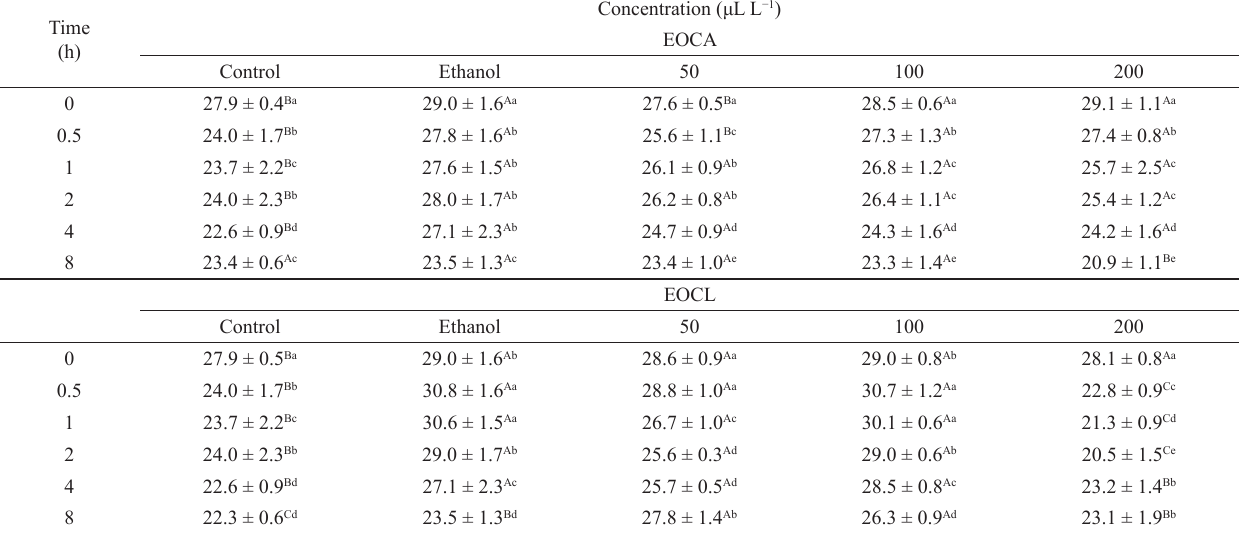
Fig 1. Net ion (Na + , K + , Cl − ) fluxes ( a-b ) and ammonia excretion ( c-d ) in silver catfish through 8 h of exposure to essential oils of Citrus x aurantium (EOCA) and Citrus x latifolia (EOCL). Values are means ± SEM. Different letters indicate significant differences between treatments (P < 0.05). Positive values indicate net influxes and negative values net effluxes. Tab. 3. Ventilatory frequency (opercular or buccal movements min −1 ) of Rhamdia quelen maintained in water with the essential oils of Citrus x aurantium (EOCA) or Citrus x latifolia (EOCL). Values are means ± SEM. Different capital letters in the rows indicate significant difference between treatments at the same time (P < 0.05). Different lowercase letters in the columns indicate significant difference between times in the same treatment (P <